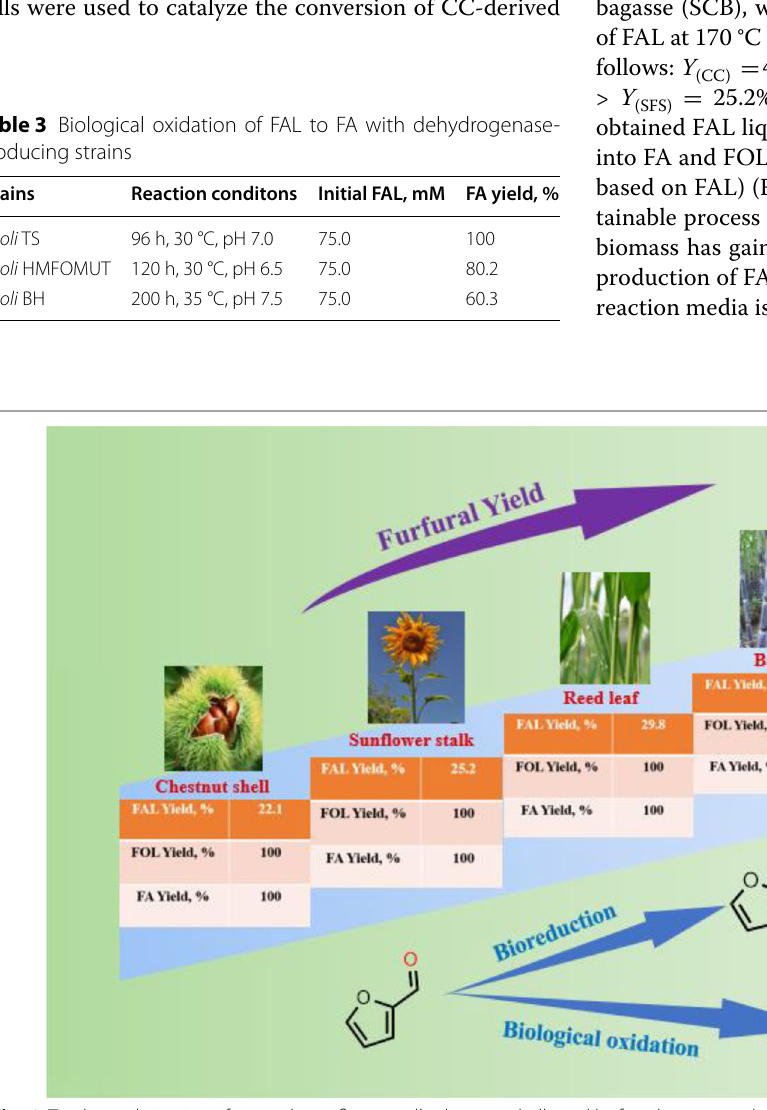
Fig. 6 Tandem valorization of corncob, sunflower stalk, chestnut shell, reed leaf, and sugarcane bagasse into FA and